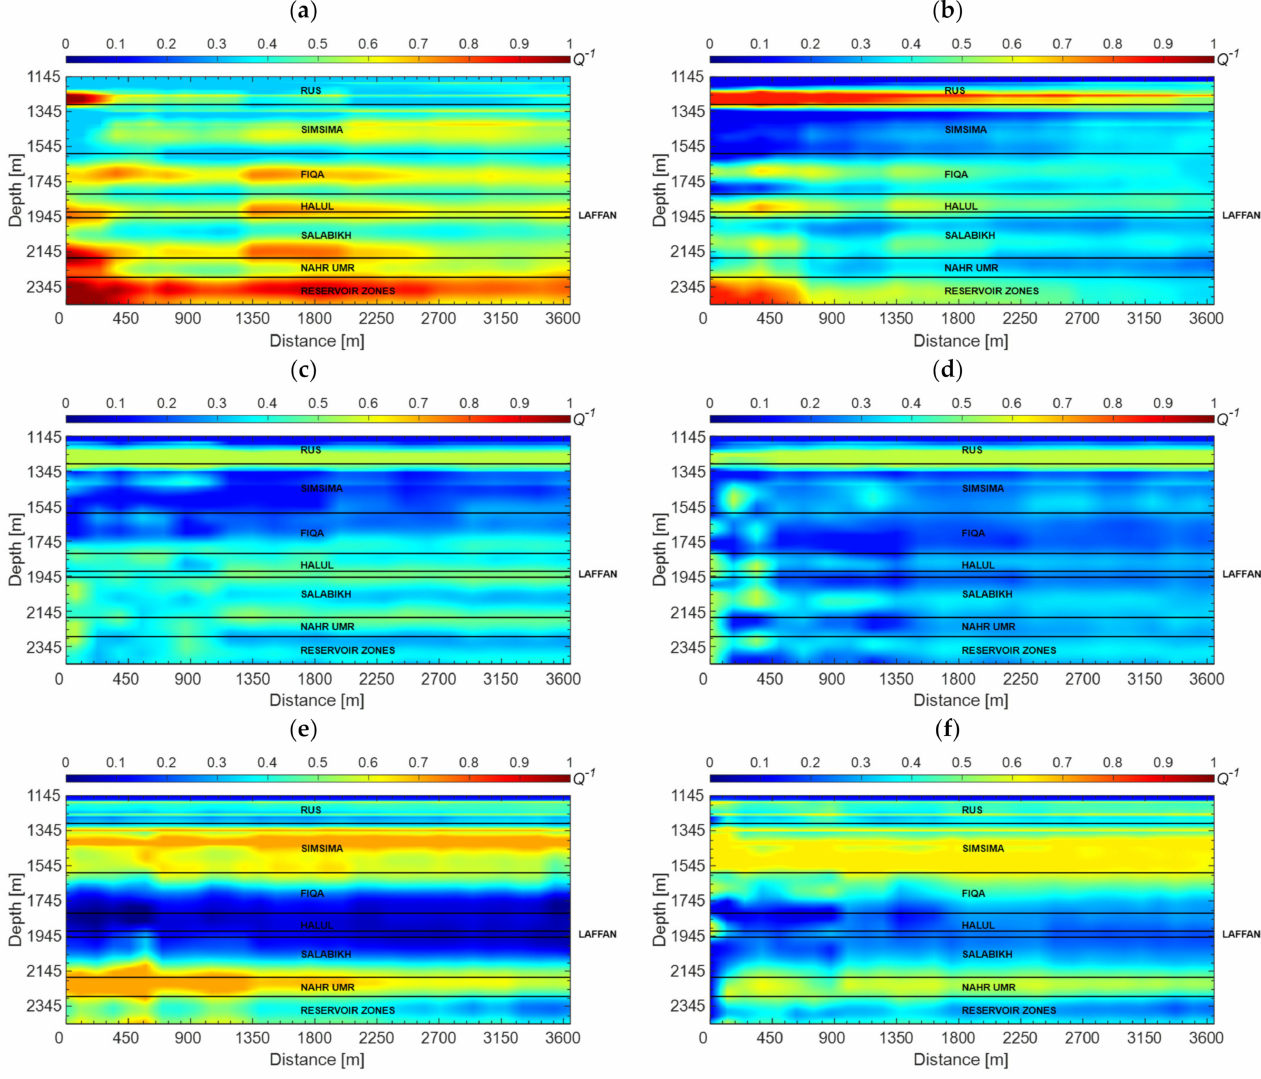
Figure 13. The 2D smoothed attenuation profiles obtained from geophone ( a , c , e ) and the summation of hydrophone and geophone ( b , d , f ) data generated by the shots belonging to the source lines highlighted by green color Figure 12a. The solid horizontal lines and the text labels indicate the tops and names of the various geological formations